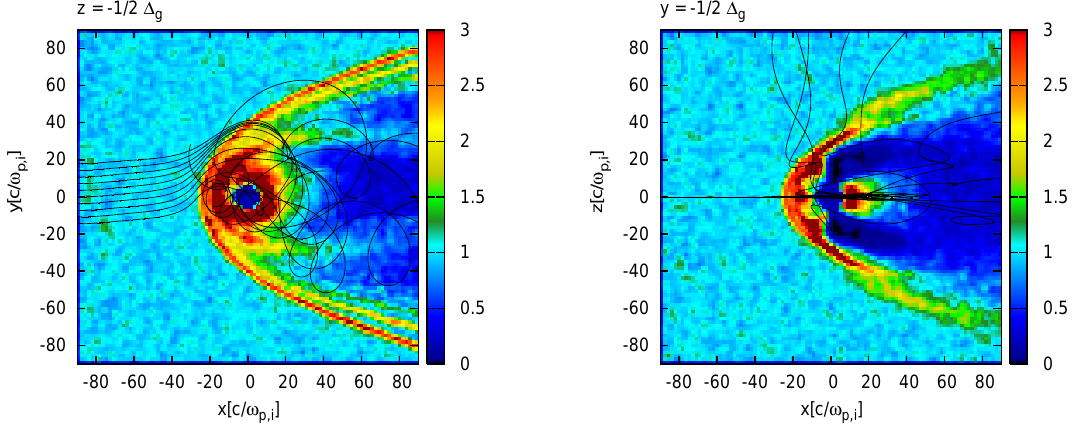
Fig. 6. Belt of trapped particles ( M ↑↓ B SW ) – Particle trajectories, starting from the intersection line of the (x,y) plane and the left face of the simulation domain. The background color plots display the normalized plasma density in the cutting planes, whereas the black lines denote the projections of ten individual particle trajectories on the cutting planes. The belt surrounding the obstacle in the equatorial plane is generated by individual particles that are influenced by the magnetic dipole field. However, because the dipole is not strong enough to capture them permanently, some particles are also able to leave the vicinity of the obstacle. The particles are gyrating around the dipole field lines that are perpendicular to the equatorial plane of the